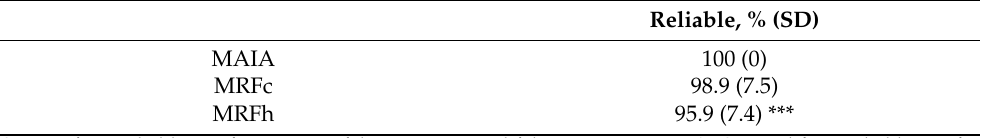
Table 3. Percentage of reliable tests over 52-weeks.